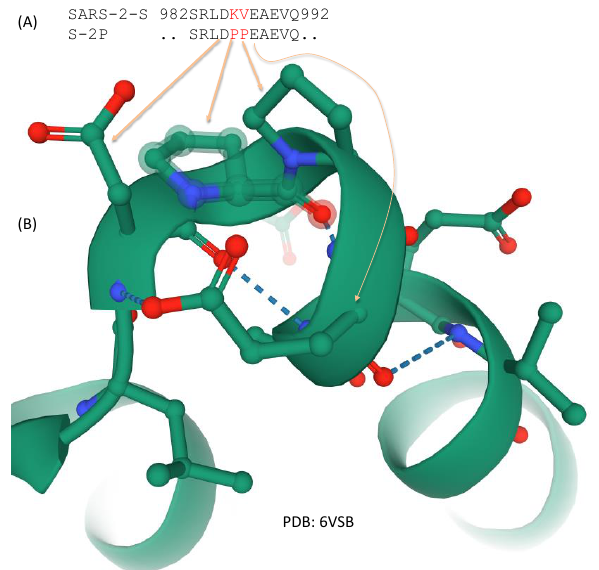
Figure 5. Two amino acid replacements that stabilize the spike protein at the prefusion state. ( A ) Amino acids KY in the native state of SARS-2-S is replaced by PP spike variant S-2P used in the FDA-approved Pfizer/BioNTech and Moderna vaccine; ( B ) Partial structure from 6VSB showing the two proline residues stabilizing the structural bend.